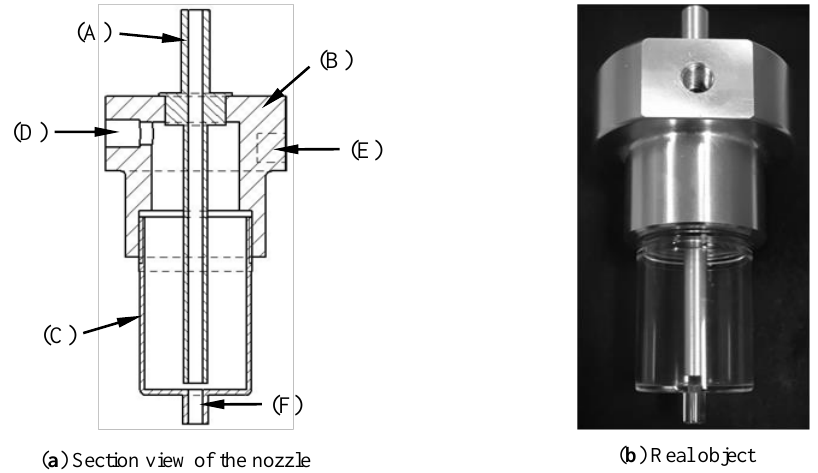
Figure 1. Structure and composition of the flow focusing/blurring